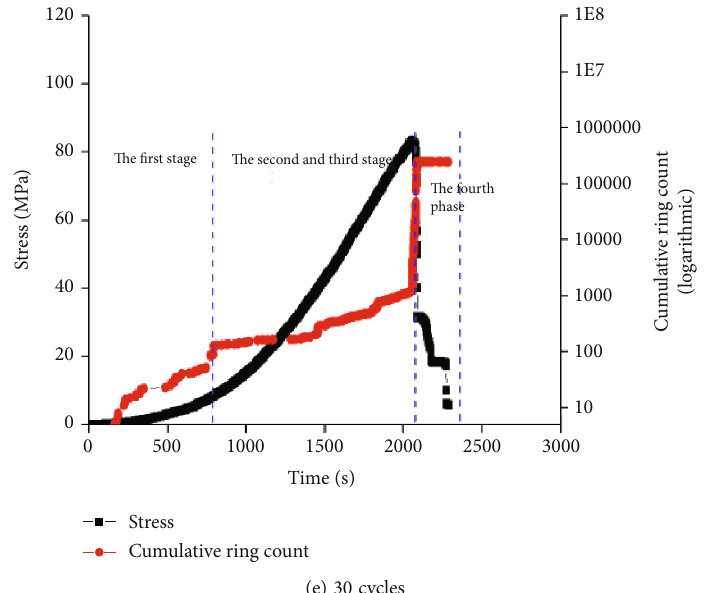
Figure 8: Rock damage and destruction cumulative ring count